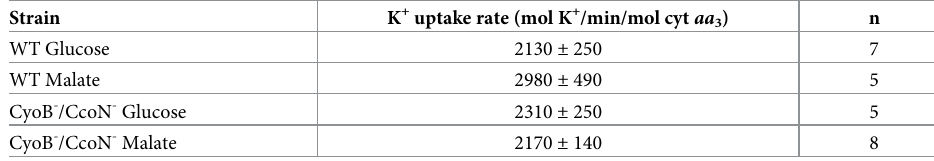
Mean ± SE of the K + uptake rates were calculated from a linear regression of the initial uptake data as shown in Fig 2. A t-test of the data indicated no significant differences (p > 0.17) between strains.